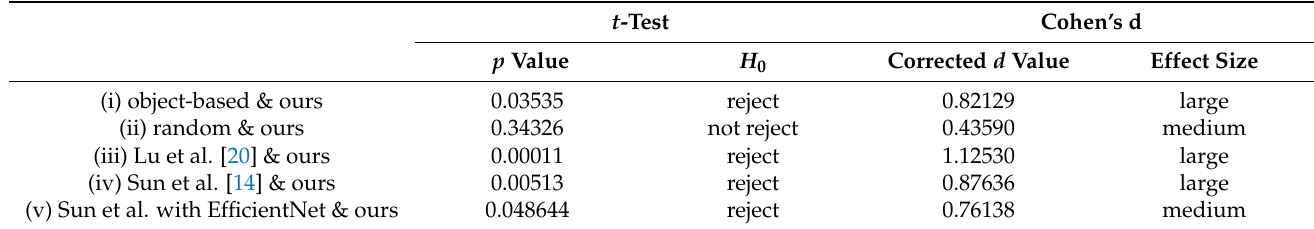
Table 2. p value for t -test and Cohen’s d